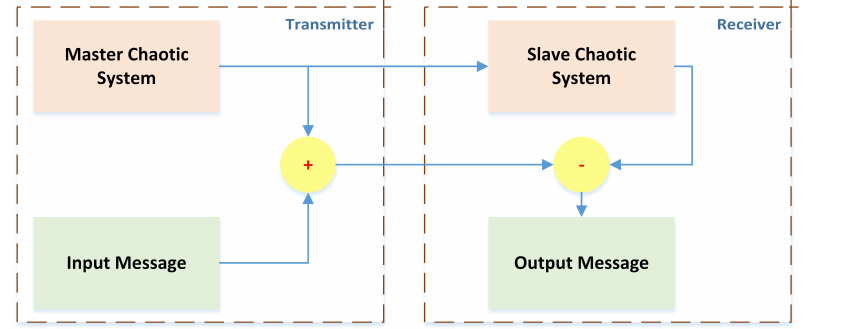
Figure 13. Example 2: Secure communication application.